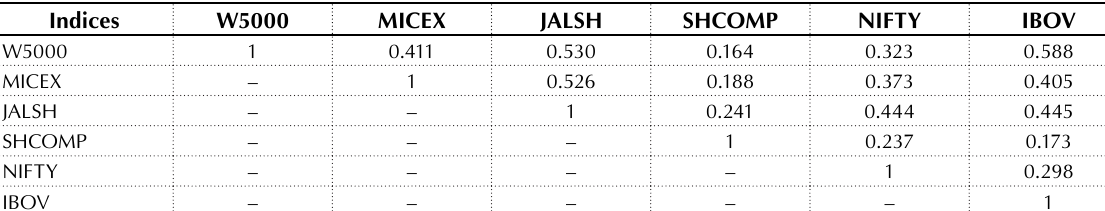
Table 2. Correlation matrix